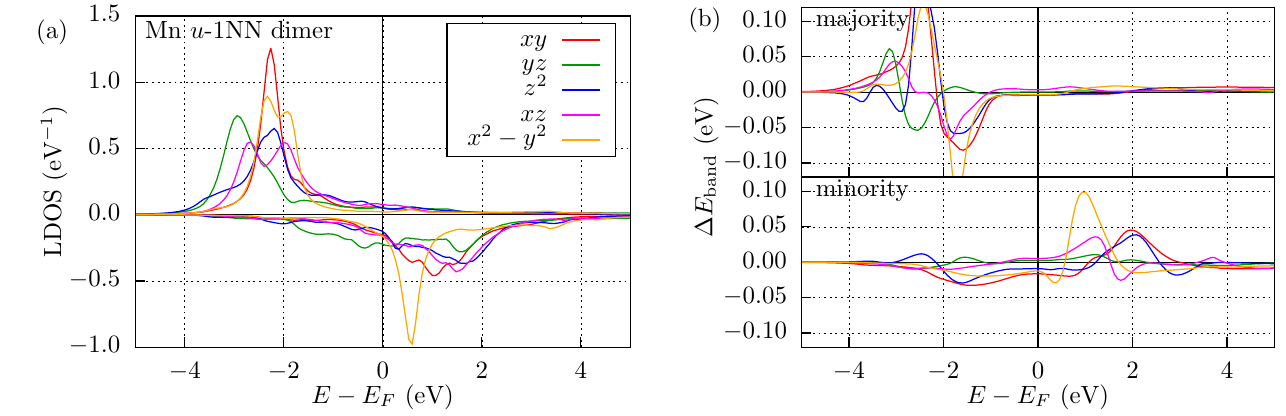
Figure 3. Local density of states and band energy differences of the Mn u -1NN dimer. ( a ) Spin-resolved LDOS in an AFM configuration as projected onto the d orbitals. ( b ) Spin-resolved band energy differences between AFM and FM alignments as a function of energy according to Equation (9). The Fermi energy is denoted by a vertical black line at E = 0. where D indicates that it is obtained from the LDOS, and γ stands for the atomic